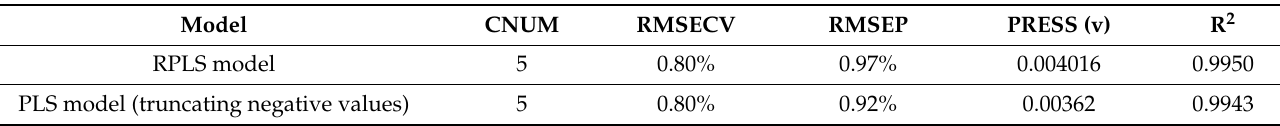
Table 4. HVO quantification PLS model results; rapeseed origin FAME/Wood origin diesel blends. Rapeseed origin FAME/Wood origin HVO (Bioverno) diesel blends.